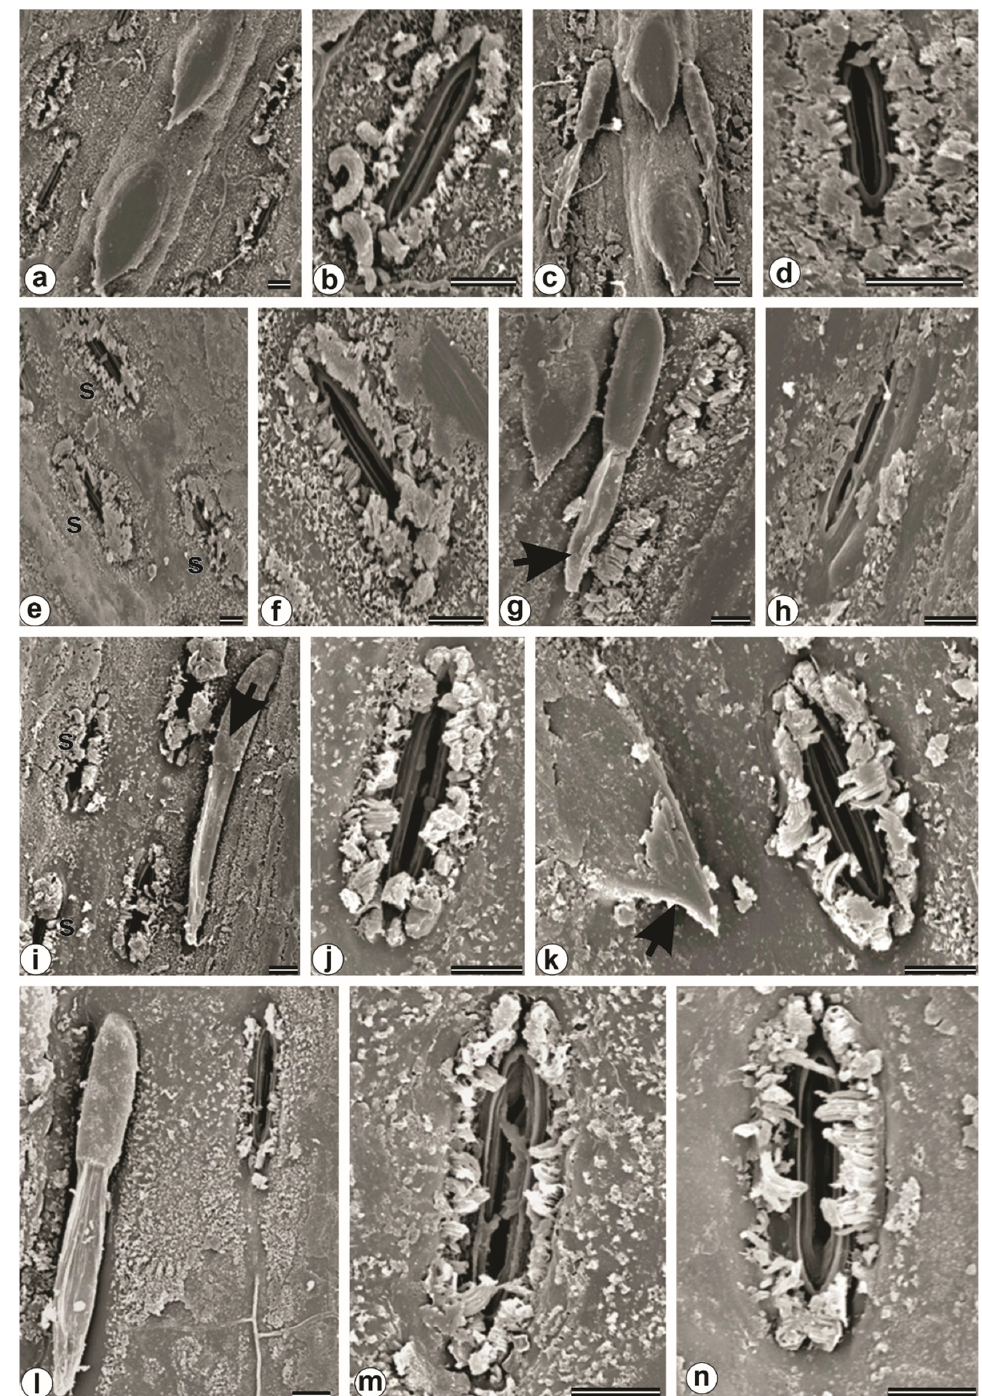
Figure 11. SEM micrograph of abaxial epidermis in four varieties (RB92579, ( a – d ); RB867515, ( e – h ); RB855536, ( i – k ); and RB72454, ( l – n )) of sugarcane. The leaf fragments were collected in rainy season ( a , b , e , f , i , j , l , m ) and dry season ( c , d , g , h , k , n ) at 8:00 to 10:00 h. Scale = 10 μ m. In ( g , i , k ), the arrow points to the epidermal hair. s. denote stomata. For more information, see Table 1.